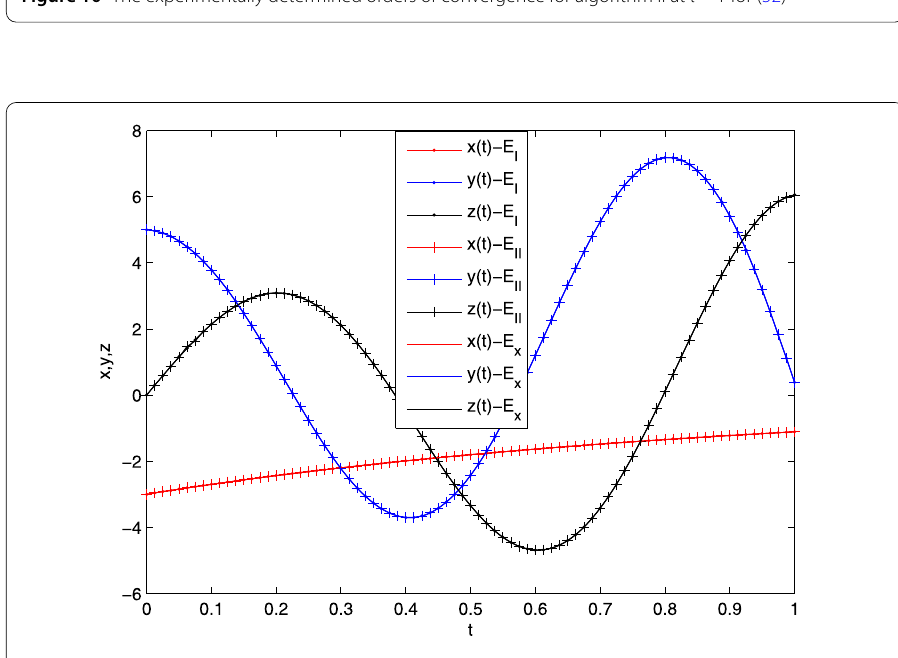
Figure 10 The experimentally determined orders of convergence for algorithm II at t = 1 for (32)